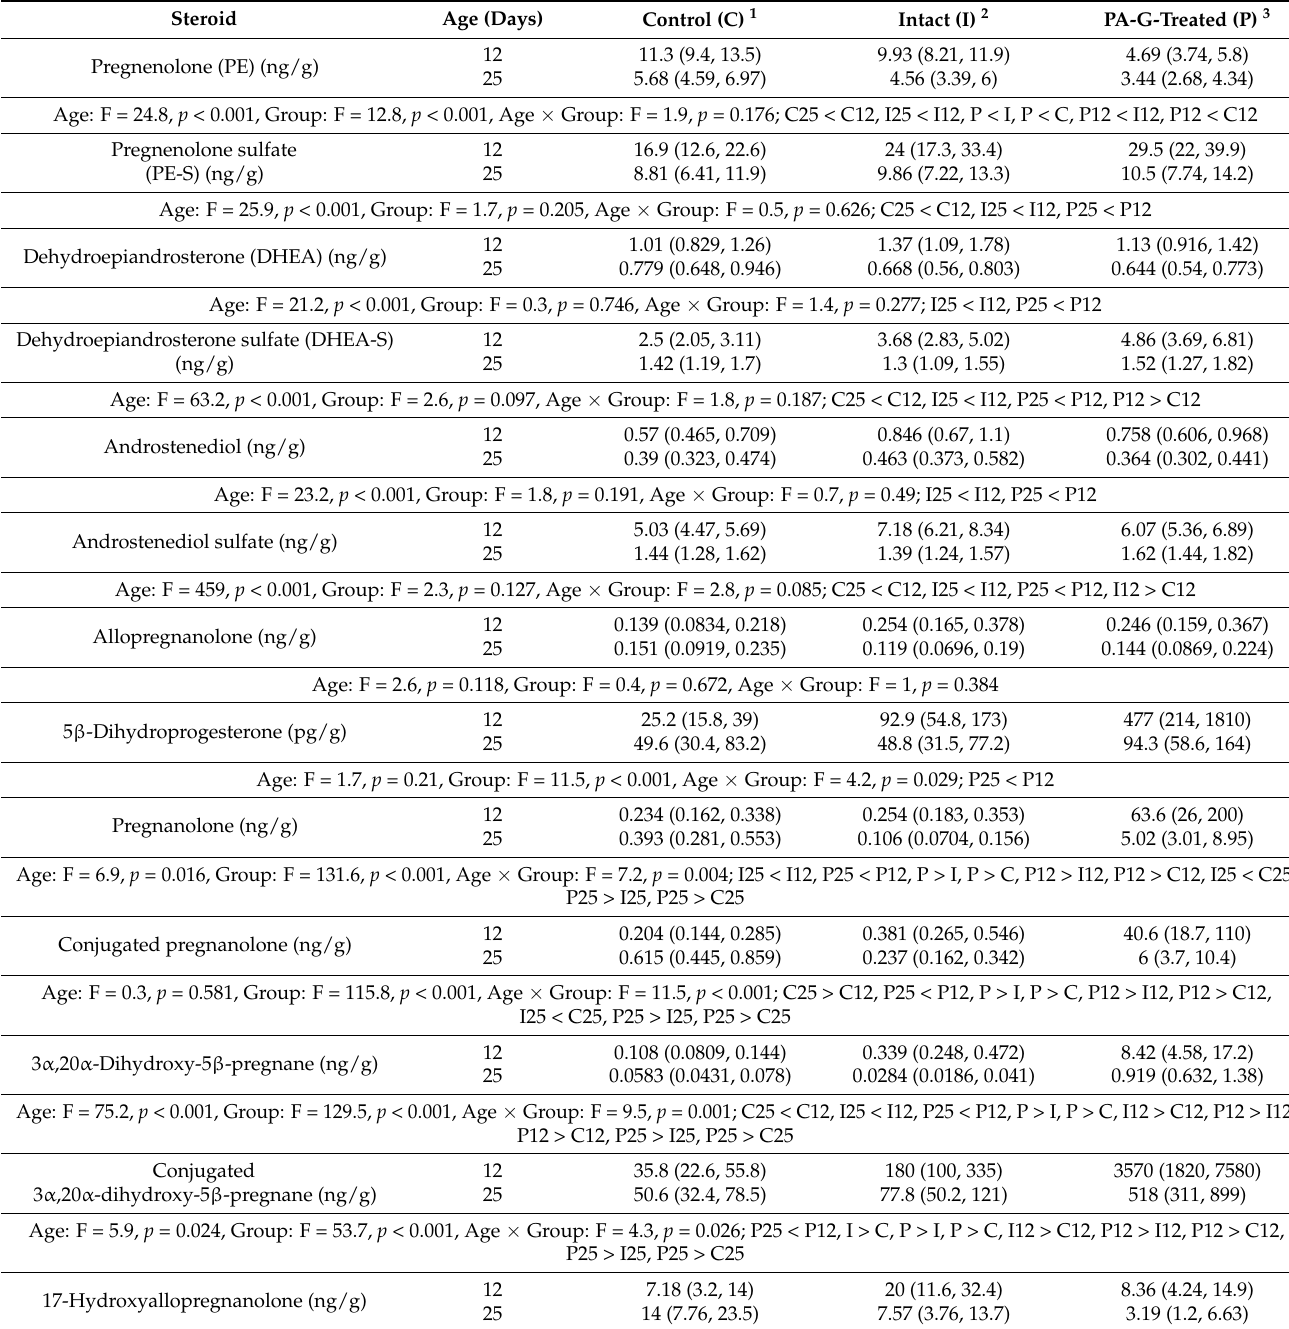
Table 1. Steroid concentrations (ng/g or pg/g) in hippocampal tissue of rats (12- and